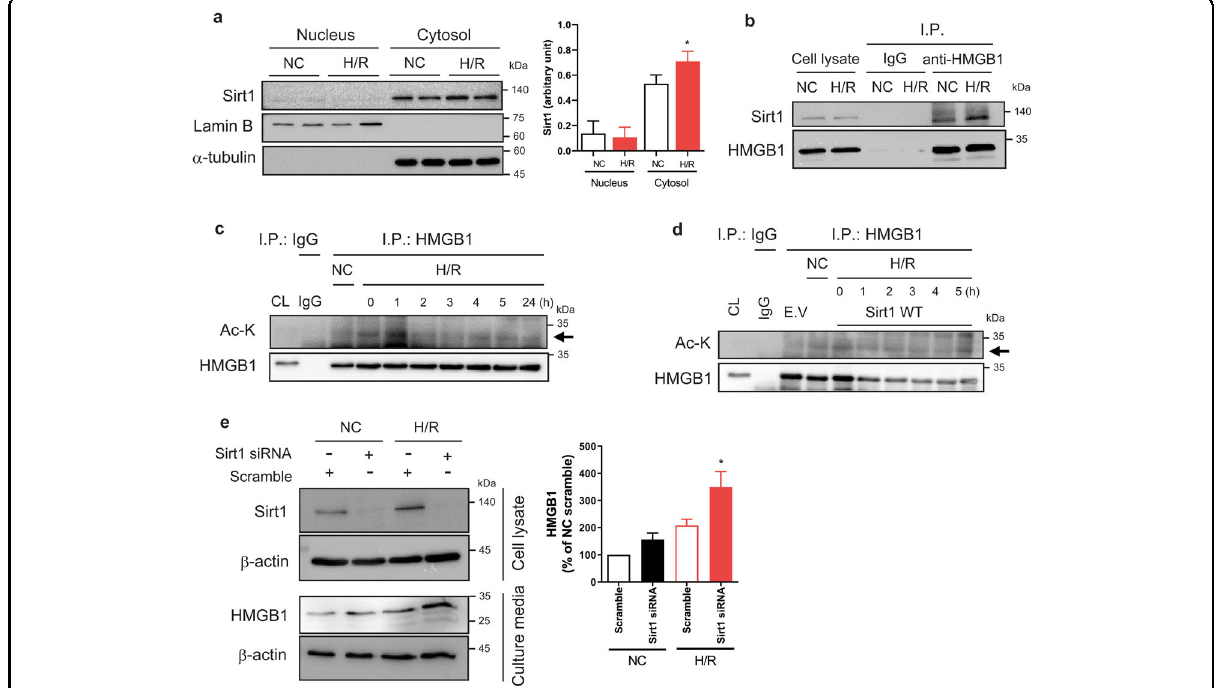
Fig. 3 H/R induced a Sirt1-dependent acetylation of HMGB1. a The expression levels of Sirt1 in nuclear and cytosolic fractions were analysed in HBMVECs with exposure to NC or H/R treatments for 6 h; α -tubulin and lamin B were used as loading controls. Representative blots are presented. Bar graph indicate the level of Sirt1 in nucleus and cytosol under normoxic (NC) or hypoxia – reoxygenation (H/R) condition ( n = 4, mean ± SD; * p < 0.05 versus cytosolic level of NC group by unpaired t- test). b HBMVECs were exposed to 6-h H/R, and 500 μ g aliquots of cell lysates were immunoprecipitated (IP) with anti-HMGB1 antibody (2 μ g/sample), and then protein binding was detected by western blotting using anti-Sirt1 and anti-HMGB1 antibodies. c, d HBMVECs ( c ) or Sirt1-overexpressing HBMVECs ( d ) were treated with H/R for 1 h and reoxygenated for the indicated times. Cell lysates (CLs) were IP with an anti-HMGB1 antibody and then acetyl-lysine (Ac-K) or HMGB1 were detected by western blot. e HBMVECs transfected with scrambled siRNA or Sirt1 siRNA were exposed to 24-h H/R. Sirt1 in CLs or extracellular HMGB1 was analysed by western blotting; β -actin was used as a loading control. Representative blots from are presented ( n = 3, mean ± SD; * p < 0.05 versus H/R treated with scrambled siRNA by unpaired t-